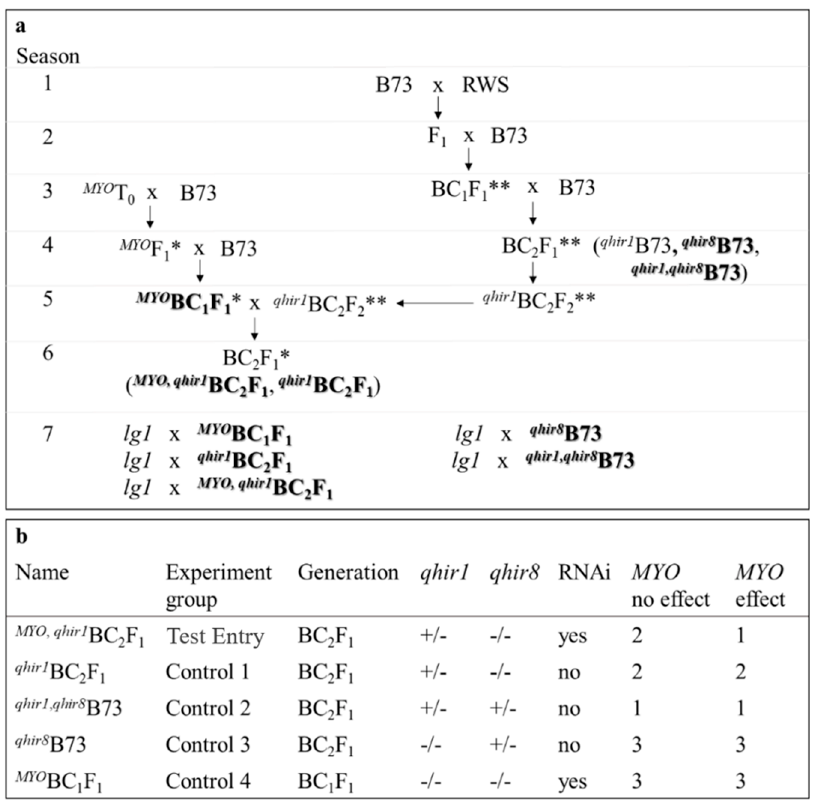
Figure 4. Schematic development of transgenic families and control groups ( a ). Bolded families are those developed for the test-cross with lg1 (Season 7). Noted, are methods of selecting transgenic plants (ELISA PAT/bar; *) and those with desired QTL regions (marker selected for qhir1 and/or qhir8 ; **). A summary of details regarding each group tested in HIR is also provided ( b ). Expected results are specified if MYO is not responsible for qhir8 ( MYO no effect) or if MYO is responsible for qhir8 ( MYO effect). Expected outcomes are numbered, with “1” noted for the highest HIR levels and “3” for the lowest HIR levels. Equal numbers imply that HIR values are comparable between the two experimental groups.